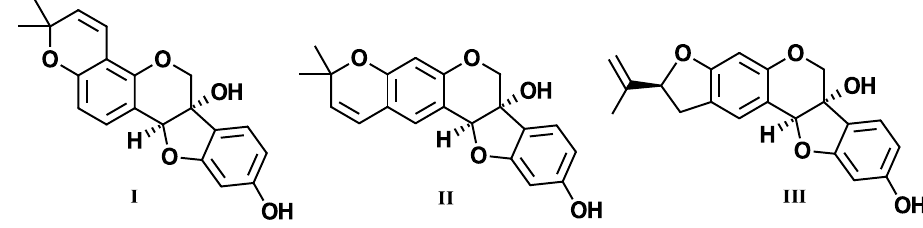
Figure 1. Chemical structures of Glyceollin I, Glyceollin II, and Glyceollin